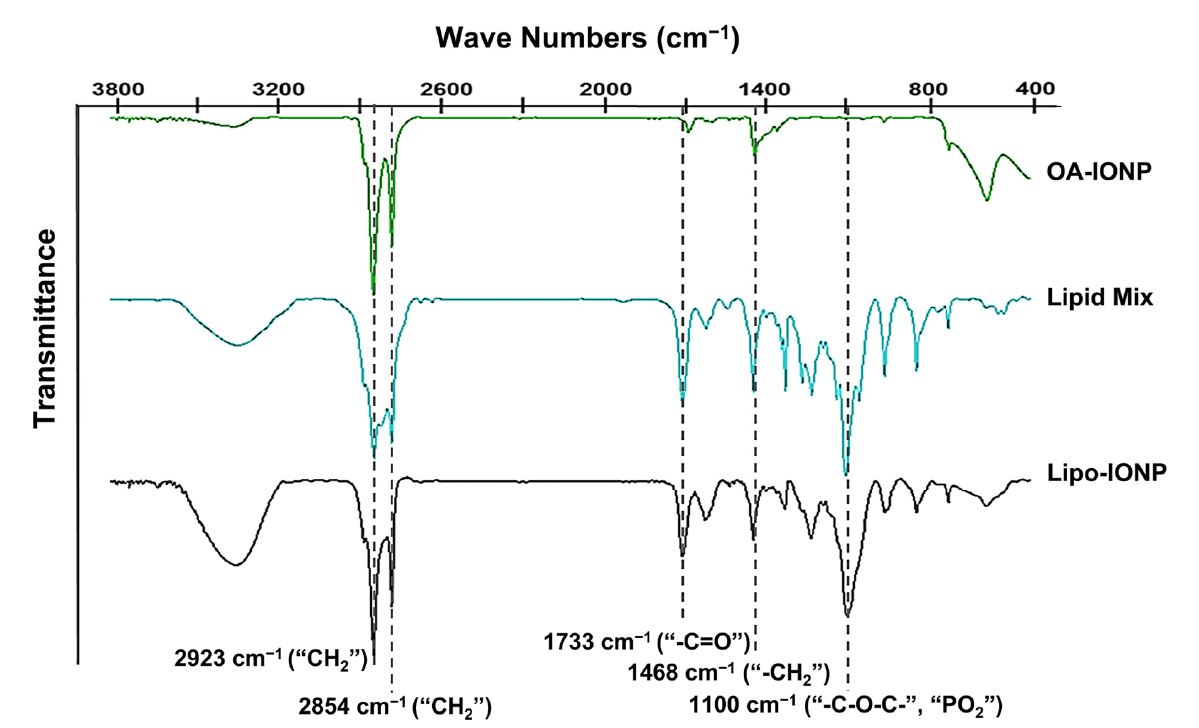
Figure 3. Fourier transform infrared (FT-IR) spectroscopic profiles of Lipo-IONP. The characteristic peaks of the samples are shown in dashed lines. The distinct peaks of the oleic acid composing OA-IONP (at 1733, 2854, and 2923 cm − 1 ) and lipid mix (at 1100 cm − 1 ) were identified from the FT-IR spectrum of the Lipo-IONP (Lipo-IONP: liposomal iron oxide nanoparticle).